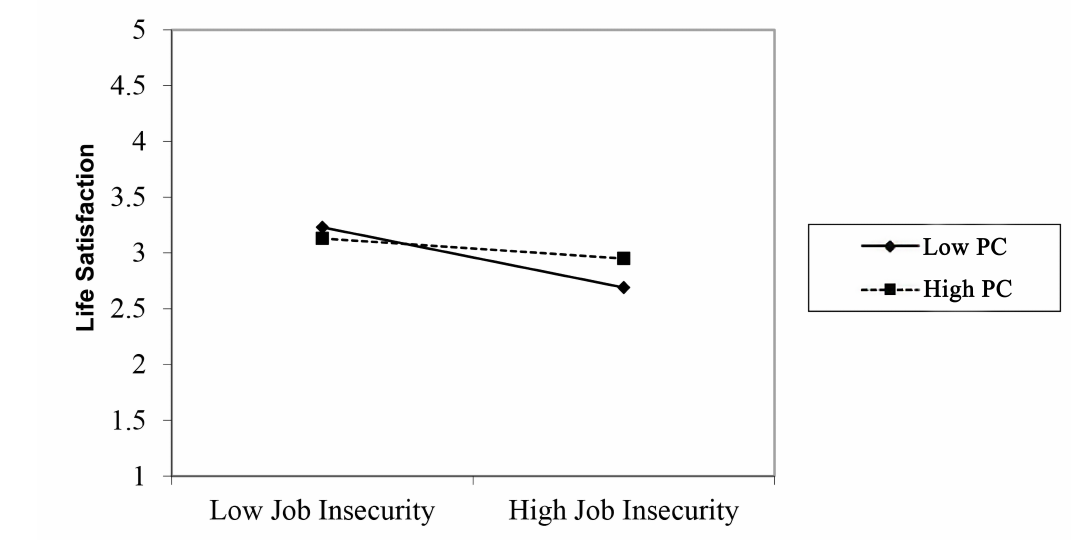
Fig. 2. The moderating effect of Perceived